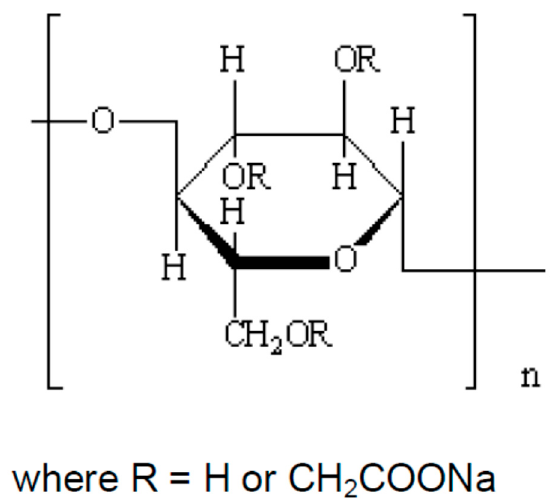
Figure 1. The structure of the repeating unit of Aqualon CMC (CMC) where R = H or CH 2 COONa. Five different surfactants were investigated for the interaction experiments. They are described in Table 1. Deionized water was used as a solvent for the polymers. Table 1. Different surfactants investigated in this work.